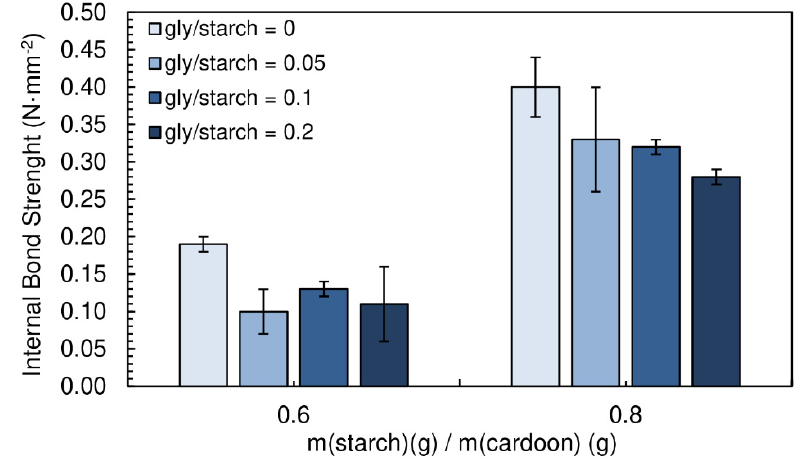
Figure 10. Effect of glycerol content on internal bond strength of the particleboards bonded with a potato starch. All adhesive formulations had a starch/cardoon ratio of 0.6 and 0.8 and cs/starch ratio of 0.05.